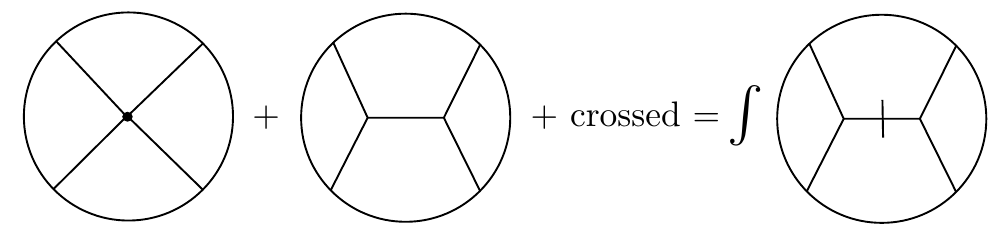
Figure 3 . The inversion integral produces the full correlator, given on the left as a sum over Witten diagrams, from the double-discontinuity in a single channel (and more generally, the t and u